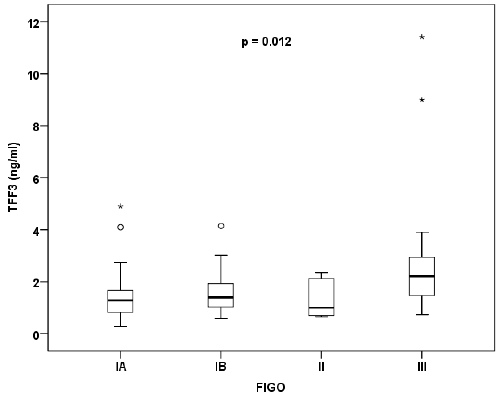
Figure 4: TFF3 serum levels in endometrial cancer stage IA (IA, n=46), stage IB (IB, n=23), stage II (II, n=12), and stage III (III, n=17) patients.